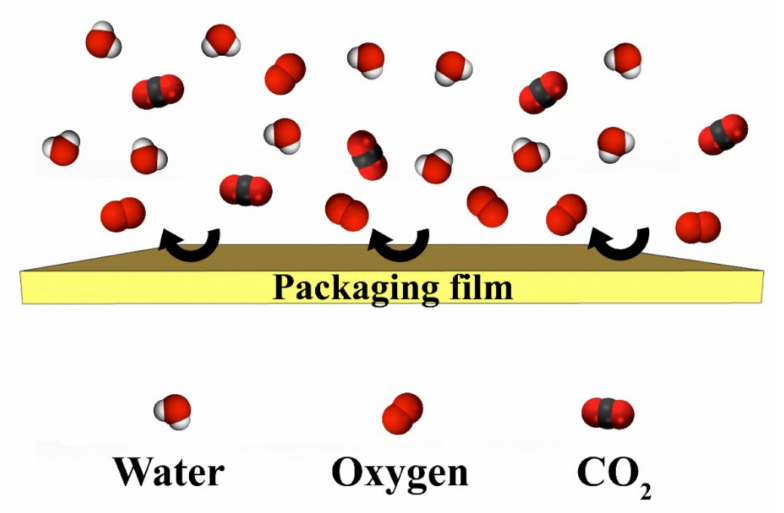
Figure 3. Schematic of barrier properties in packaging films against water, oxygen, and carbon dioxide